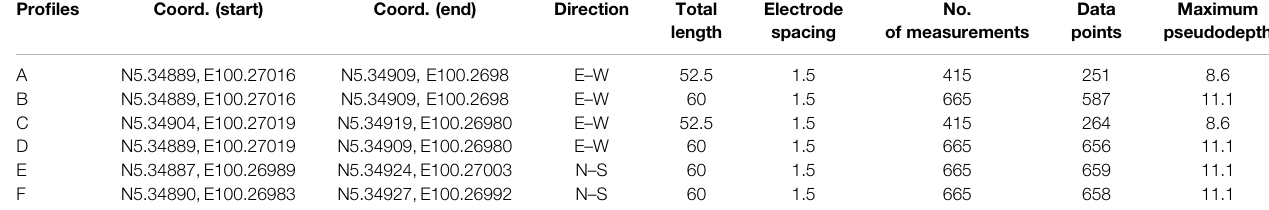
TABLE 3 | Characteristics of the six electrical resistivity tomography (ERT) pro fi les acquired using 42 steel electrodes with Wenner – Schlumberger array. Pro fi les Coord. (start) Coord. (end)